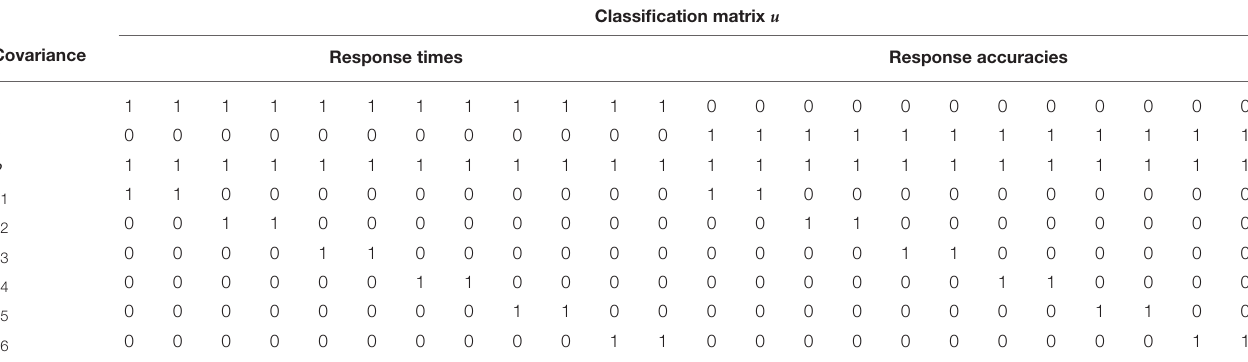
TABLE 6 | The additive covariance structure of the BCSM allows a varying speed-accuracy trade-off between blocks of two items. Classification matrix u Covariance Response times Response accuracies